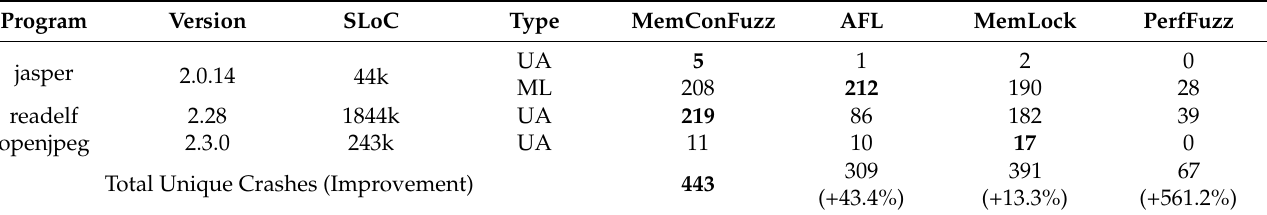
Table 1. Number of heap memory consumption